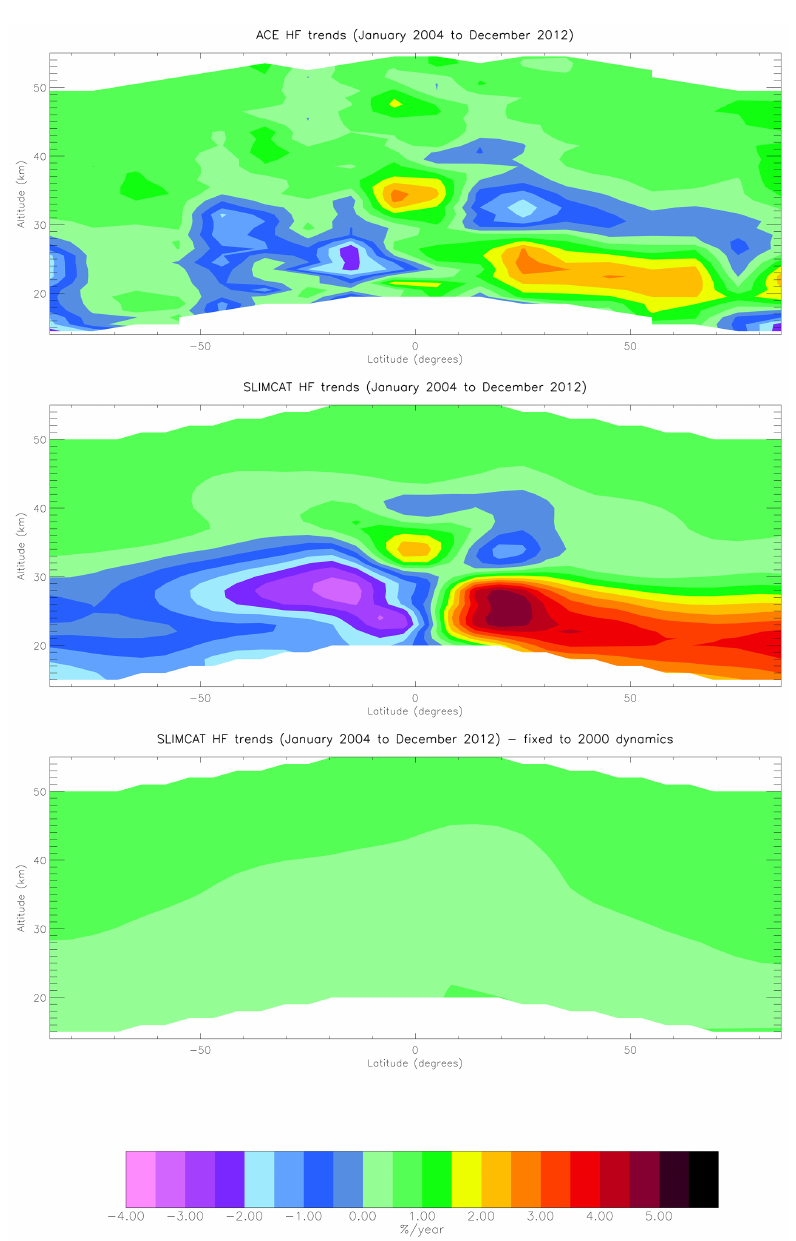
Figure 9. Trends in the growth of HF (%year − 1 ; January 2004 to December 2012) for ACE-FTS and SLIMCAT as a function of latitude and altitude. A full discussion of these trends is provided in the